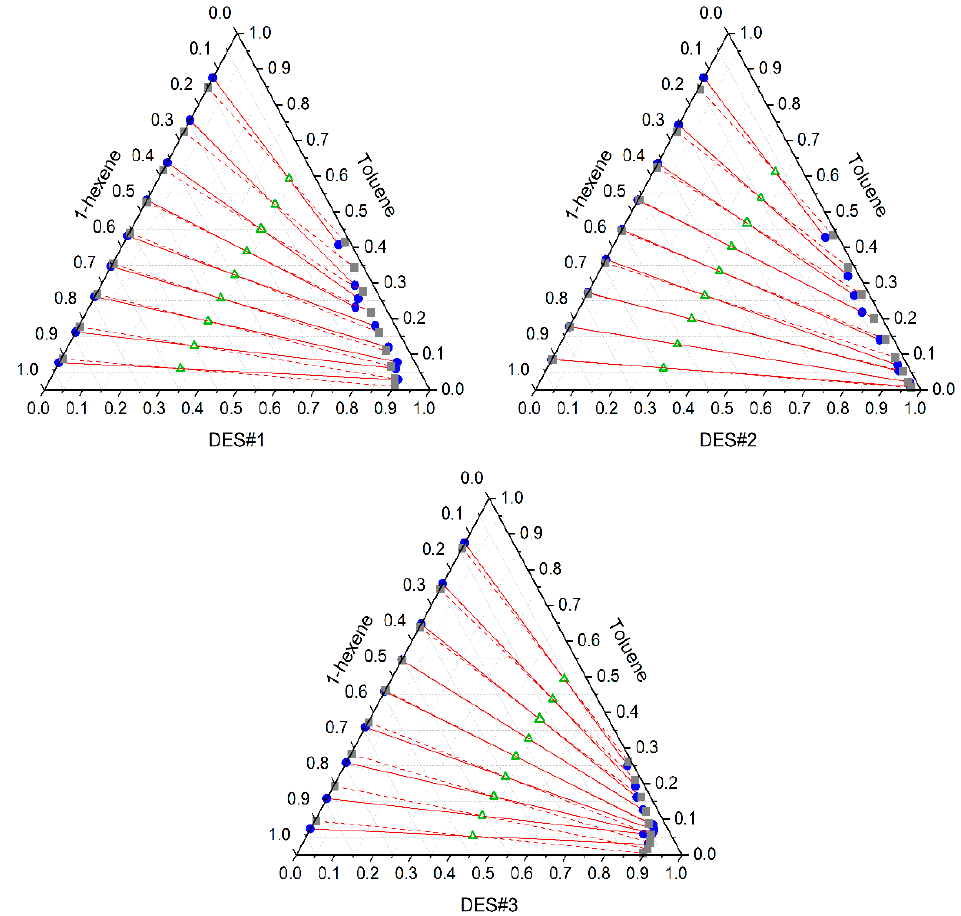
Figure 4. Liquid–liquid equilibrium diagram for the ternary systems {1-hexene (1) + toluene (2) +